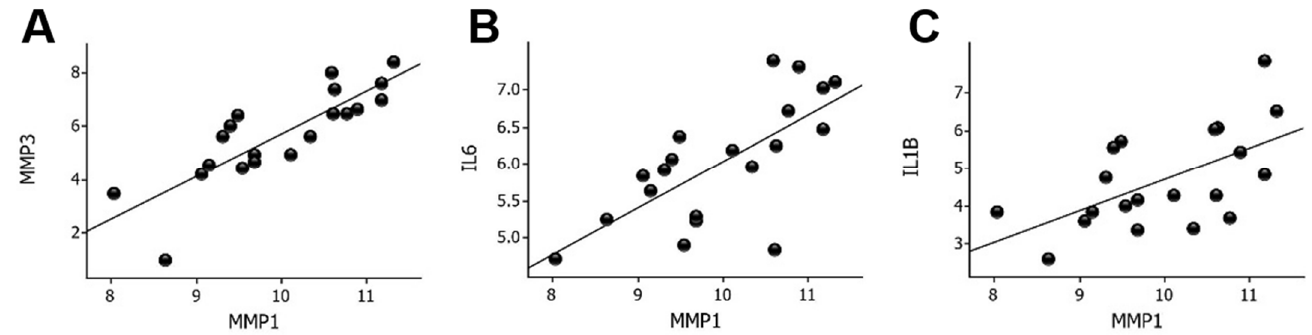
Figure 2. Correlation between MMP1 mRNA levels and MMP3 ( A ), IL6 ( B ), and IL1B ( C ) mRNA levels in wounds. Log2-transformed expression values are shown on the y- and x-axes. MMP, matrix metalloproteinase; IL, interleukin.